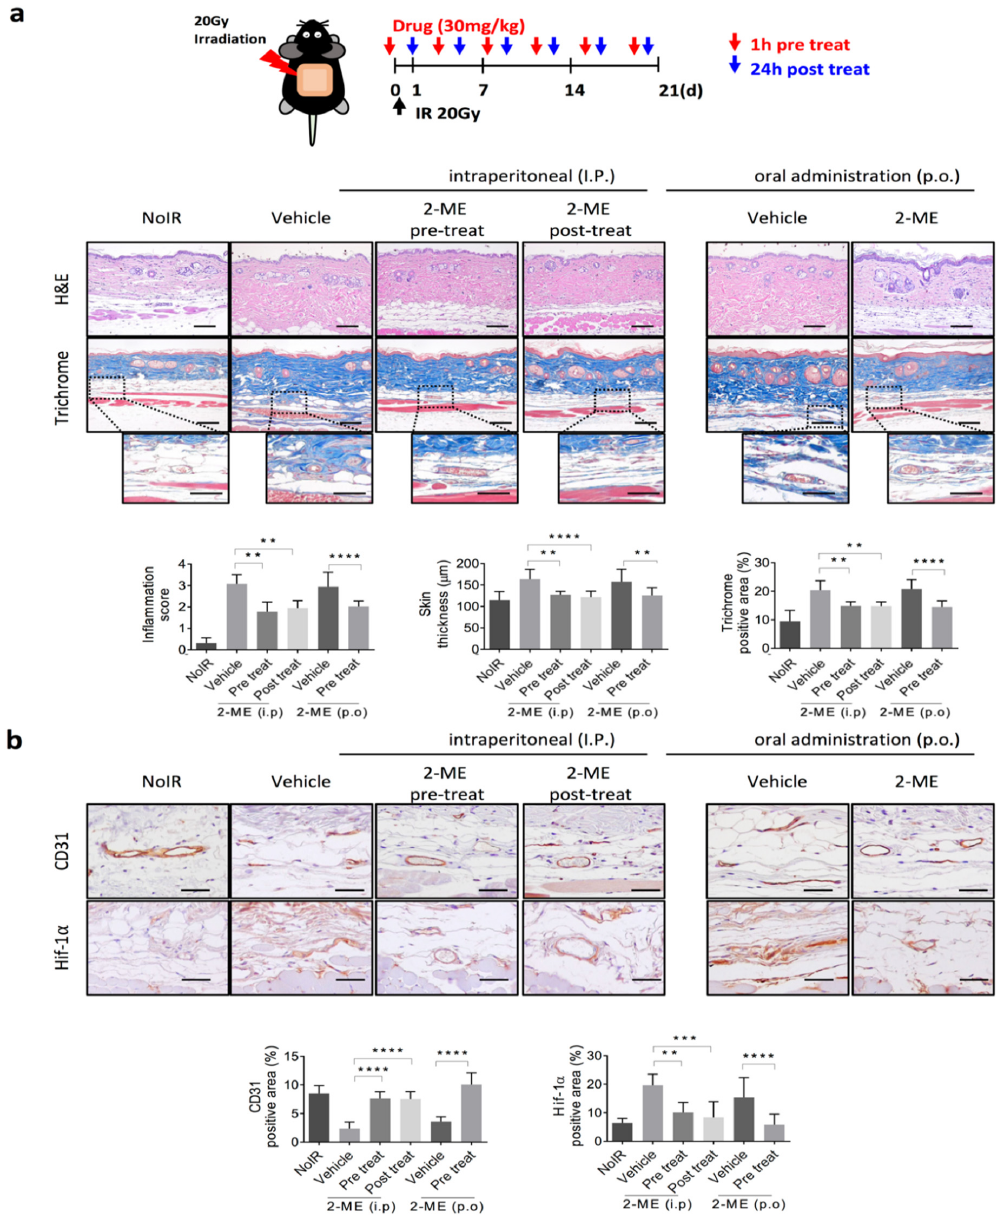
Figure 1. 2-ME inhibits radiation-induced skin vascular injuries, perivascular collagen deposition, and upregulated HIF-1 α expression. C57BL/6 mice skin were irradiated with 20 Gy using a 4-cm field. Pre-treated mice were injected with 2-ME (30 mg/kg; intraperitoneally or oral administration) 1 h before irradiation a total of 6 times in 3 weeks. Post-treated mice were intraperitoneally injected 24 h after irradiation a total of 6 times in 3 weeks. ( a ) H&E staining and Masson’s Trichrome staining in skin tissues 3 weeks after irradiation with or without 2-ME. Scale bar = 100 μ m; scale bar of the cropped images = 50 μ m. Quantification of collagen deposition area per field as an average of five fields (magnification, 200×, n > 3). Scoring of inflammation, fibrosis grades, and collagen deposition is shown. ( b ) Immunohistochemical detection of CD31 and HIF-1 α in skin tissues 3 weeks after irradiation. Scale bar = 50 μ m. Quantification of CD31 + area and HIF-1 α + area per field as an average of five fields (magnification, 200×, n > 3). For all graphs, error bars indicate the SD from n > 3 biologically independent experiments (one-way ANOVA for multiple comparisons). ** p < 0.01, *** p < 0.001, and **** p < 0.0001.